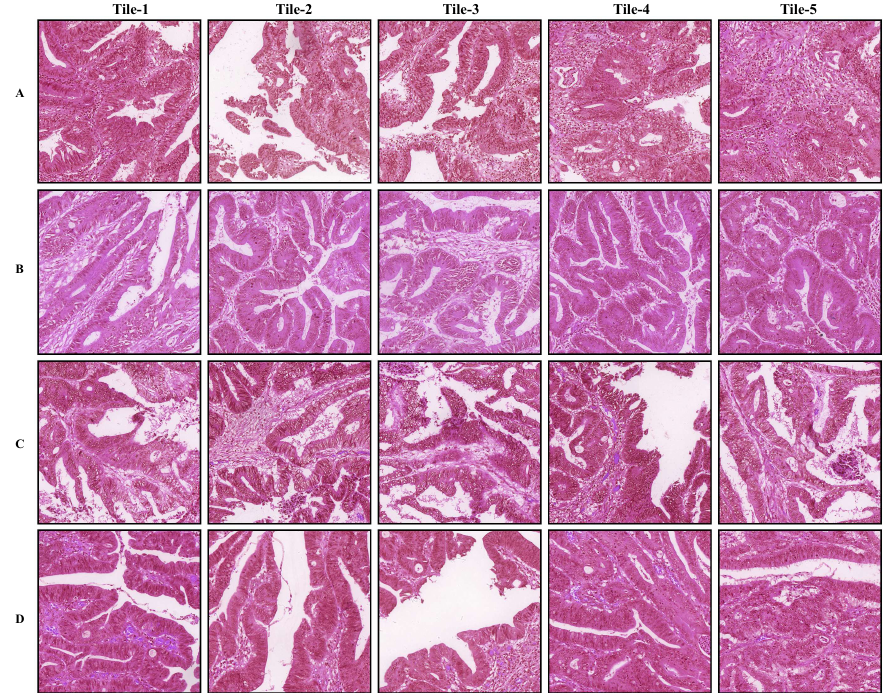
Figure 4. Representative tiles of tumor classification using 5 × tiles of the whole slide images (WSIs). The ( A – D ) samples are randomly selected from the testing set. In each row, tiles 1–5 are patches from the same WSI.